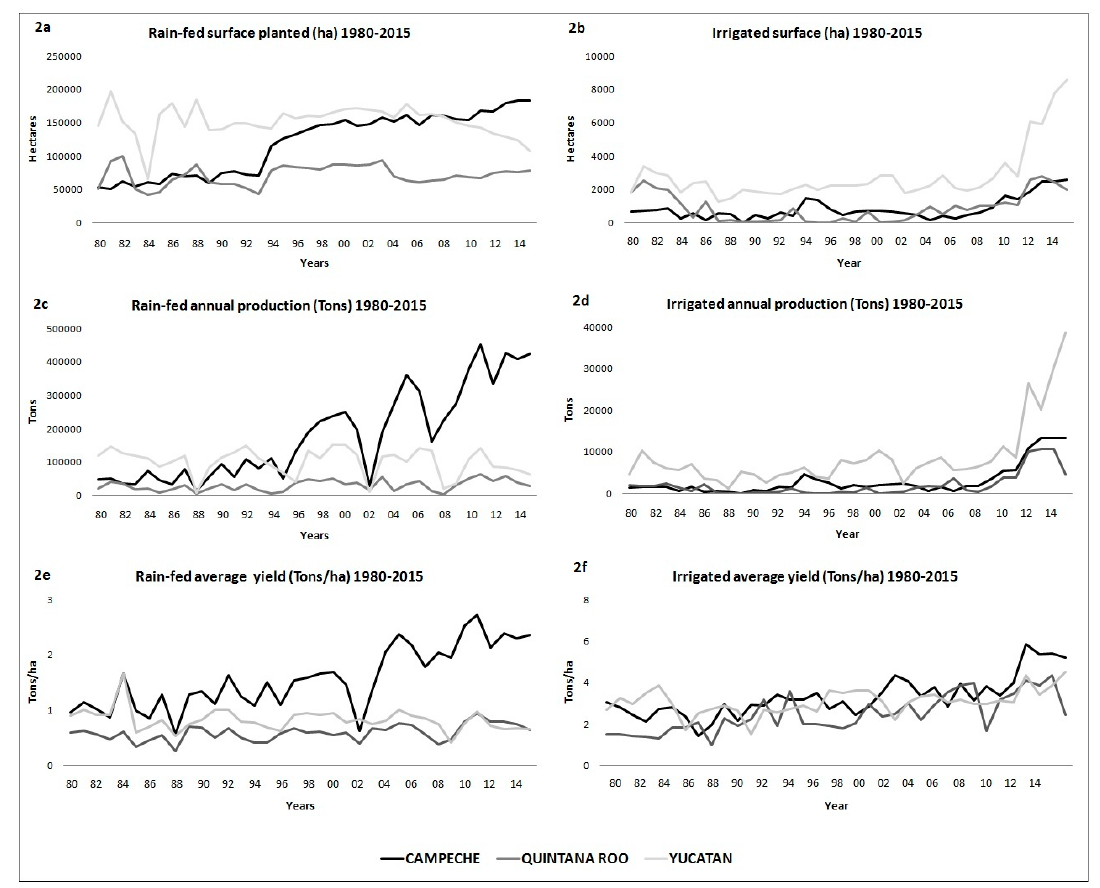
Figure 2. Surface area planted in maize, annual maize production, and average maize yield